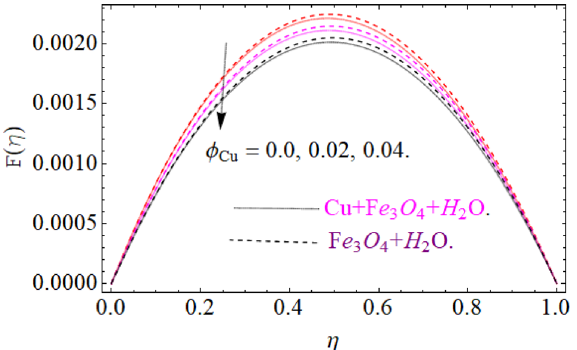
Figure 4. Impression of φ Cu on F( η ), When M = 0.2, φ Fe 3 O 4 = 0.02, Ec = 0.1, Pr = 6.2 .